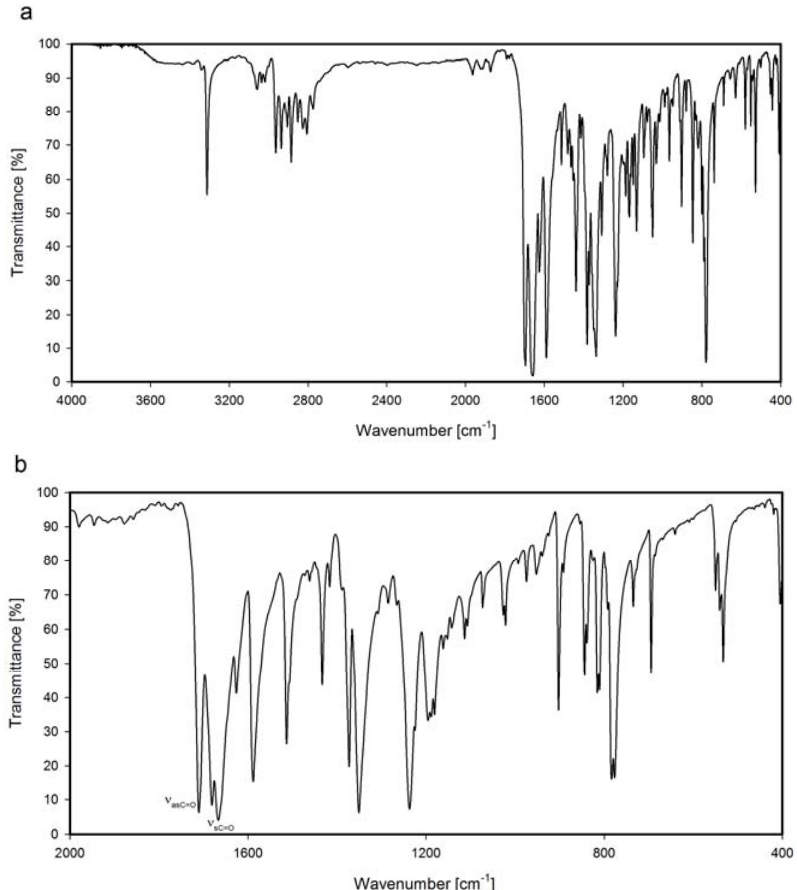
Figure 3. FTIR spectrum of N,N -bis[3-(1,8-naphthalimide)propyl]amine ( NP3 );